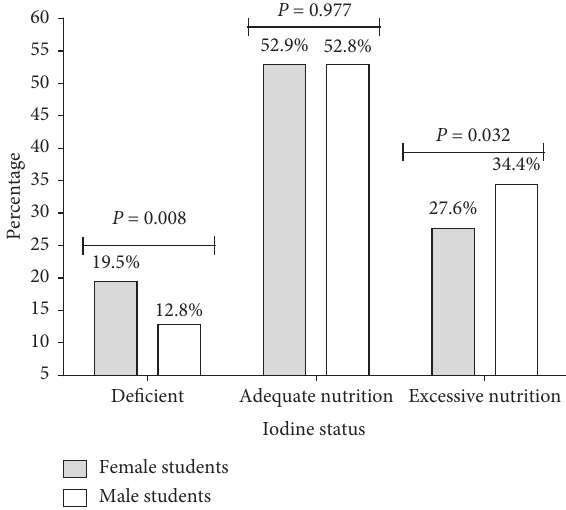
Figure 2: Iodine status of the school-aged children (6–12 years) in the Ashanti region of Ghana stratified by